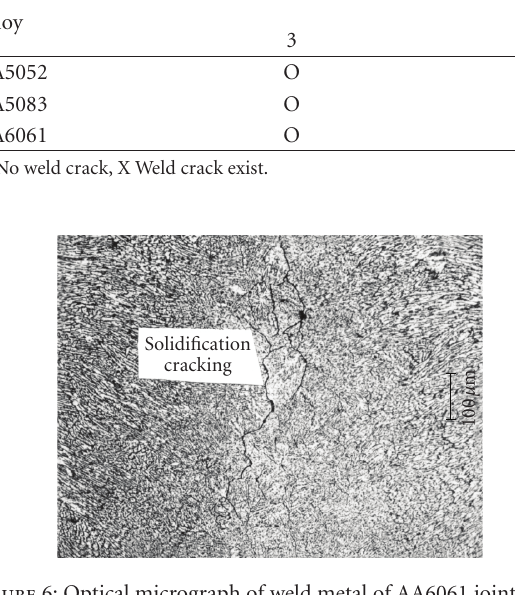
Figure 6: Optical micrograph of weld metal of AA6061 joint made using P = 5kW, S = 4m/min, Dd = 0, 15l/min argon.